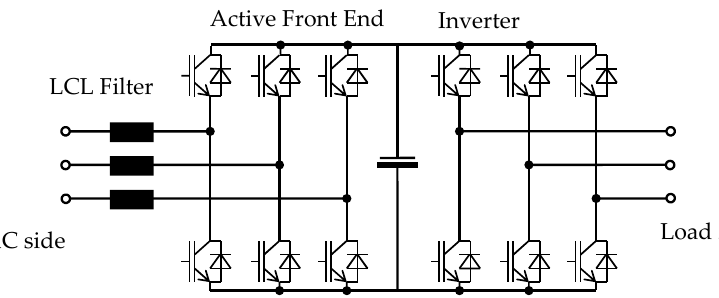
Figure 1. Application of an IGBT ‘Active Front End’ to an AC PWM